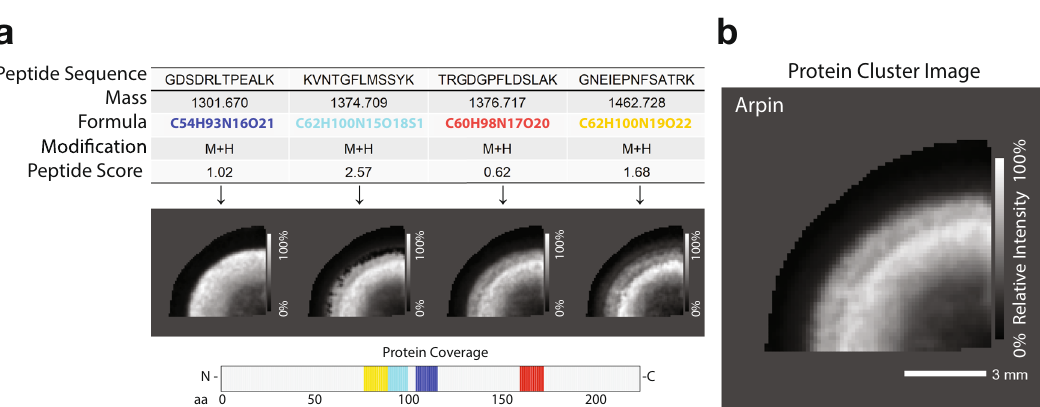
Fig. 2 Visualisation of HIT-MAP cluster imaging output in the bovine lens. a Example outputs from HIT-MAP visualisation of bovine lens protein arpin, showing the series of peptide data and peptide ion image for a given parent protein, as well as protein coverage (scale bar = 3 mm). b Visualisation of the integrated clustering of each individual peptide ion image to demonstrate the overall summary spatial distribution of an annotated protein. Intensity scales represent relative intensity from 0 to 100%. Scale bar = 3